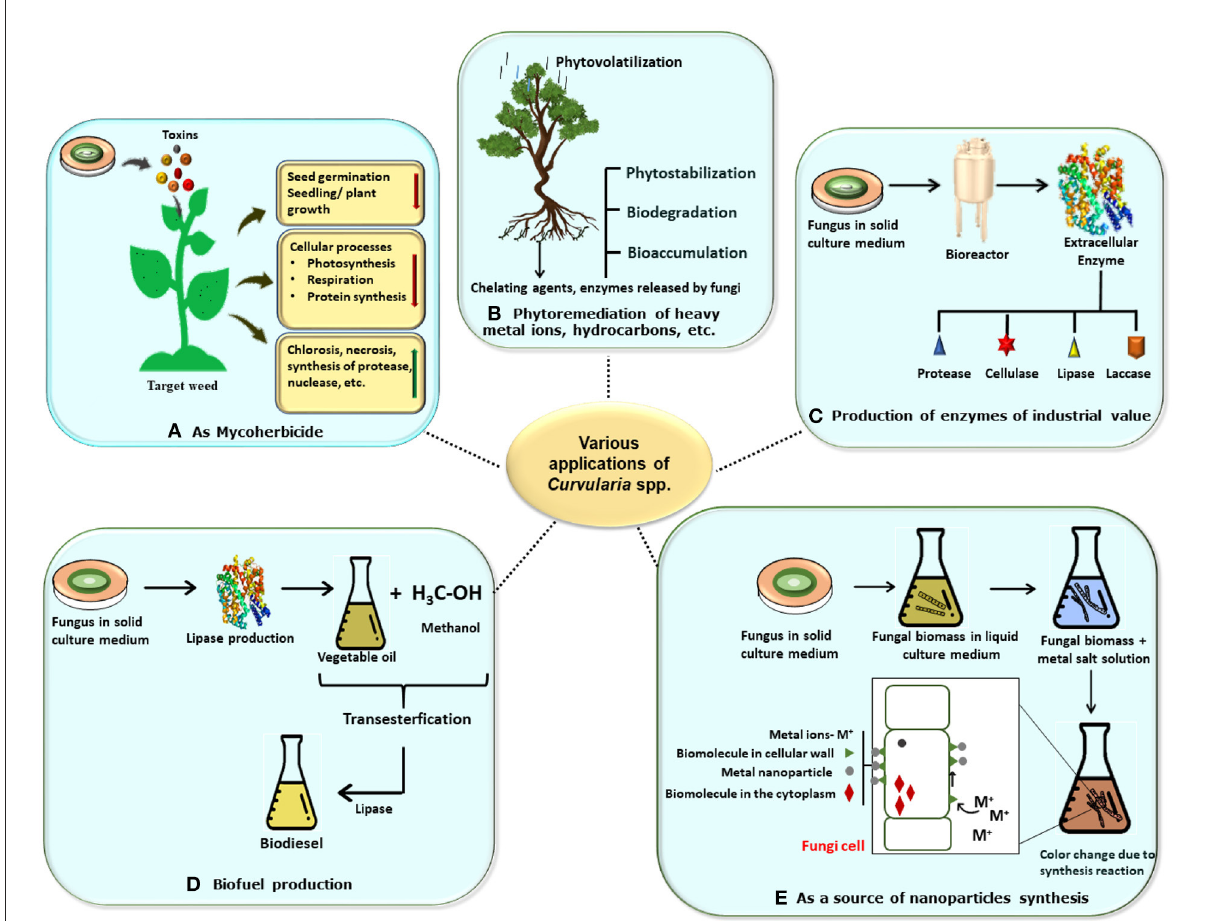
FIGURE6 Schematic representation of various biotechnological applications of Curvularia spp. (A) Mycoherbicide: Curvularia spp. have great weedicidal and herbicidal capacity due to secretion of mycotoxins. Its lowers the seedling or plant growth, decrease cellular activities, and increase necrosis in host plant, thus it can be used as potent mycoherbicide. (B) In bioremediation: Curvularia spp. are a good bioremediating agents which bioremediate the plant from heavy metals and pollutants by various methods like phytovolatilization, biostabilization, biodegradation, and bioaccumulation. (C) In enzyme production: Large scale productions of various enzymes like lipase, laccase, cellulose, etc. which has industrial economic value can be obtained by using the fungus. (D) In biofuel production: Biofuel and biogas can be produce by using fungus